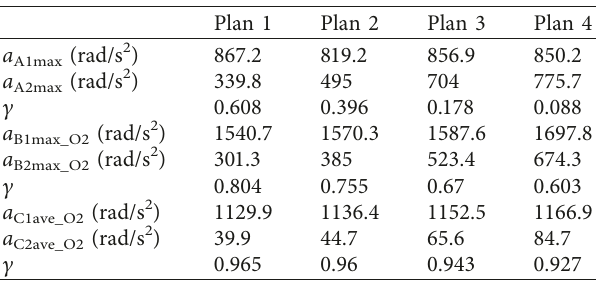
Figure 17: The 2 nd order angular acceleration under different stiffness schemes in Phases B and C. (a) The primary side result; (b) the secondary side result. Table 7: DMF vibration control performances under different stiffness